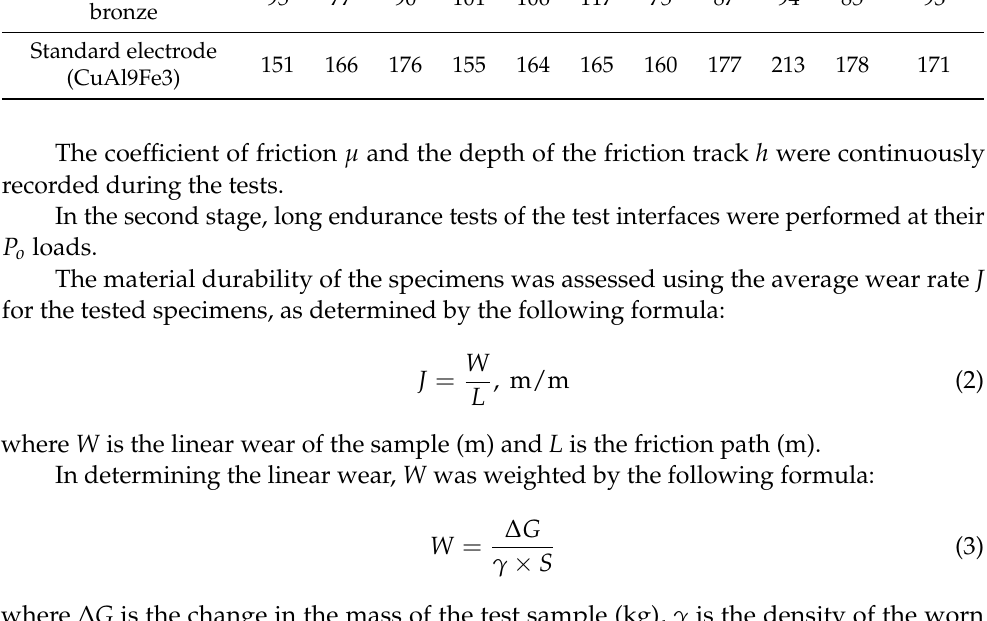
Table 5. Microhardness of the test materials. Material Simultaneous Indicators for Vickers H µ (HV) Electrode from